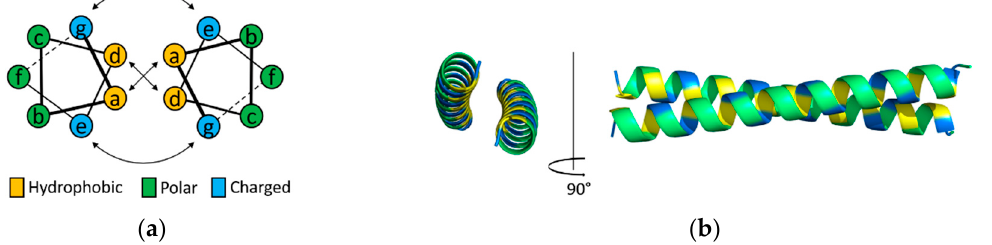
Figure 1. Structure and interface of a dimeric coiled-coil; ( a ) A helical wheel diagram that presents amino acid residues located at the characteristic positions labeled abcdefg . Their interactions at the interface are indicated by arrows; ( b ) Top (left) and side view images (right) of the backbone structure. The structural model was generated using CCBuilder 2.0 [11].